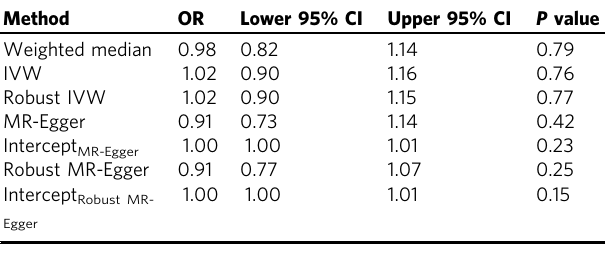
Egger n = 28 SNPs. Results are from two-sample Mendelian randomization analyses and P values are two-sided. Results are unadjusted for multiple comparisons. Source data are provided as Source Data fi le. IVW inverse-variance weighted, OR odds